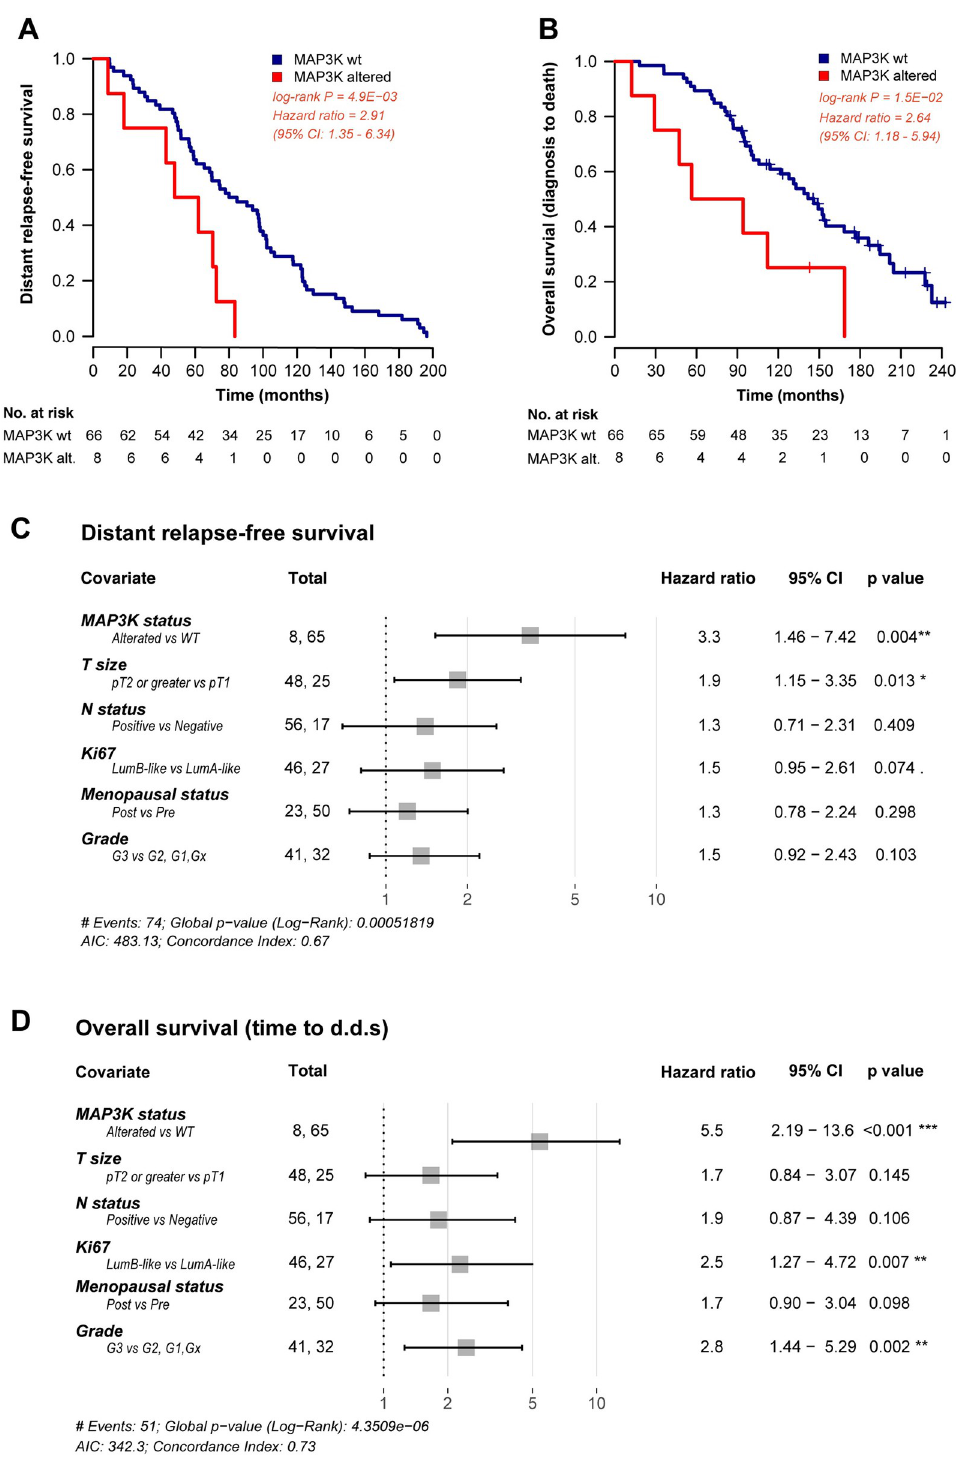
Fig 3. Association between MAP3K alterations and clinical outcome. Kaplan Meier curves displaying distant relapse- free survival (DRFS) (A) and overall survival (OS) (B) in patients with MAP3K gene alteration (red curves) as compared with patients with wild-type MAP3K status (blue curves). Forest plots indicating the hazard ratios for DRFS (C) and OS (D), and the corresponding confidence intervals, in MAP3K- altered and MAP3K- wild type patients. Multivariable Cox analysis is adjusted for tumor size, lymph node involvement, Ki67, menopausal status and tumor grade of the primary tumor. https://doi.org/10.1371/journal.pgen.1010563.g003 PLOS Genetics | https://doi.org/10.1371/journal.pgen.1010563 January3,